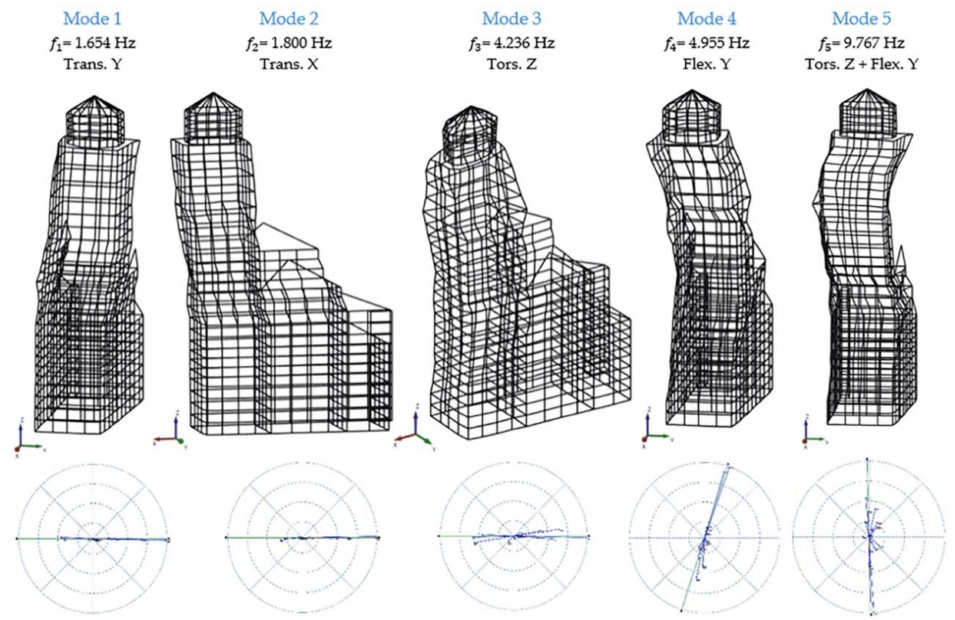
Figure 5. Experimental model: mode shapes, frequencies and complexity